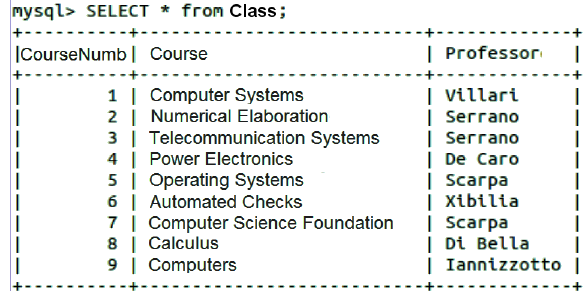
Figure 8. Example table “Class” on MySQL.